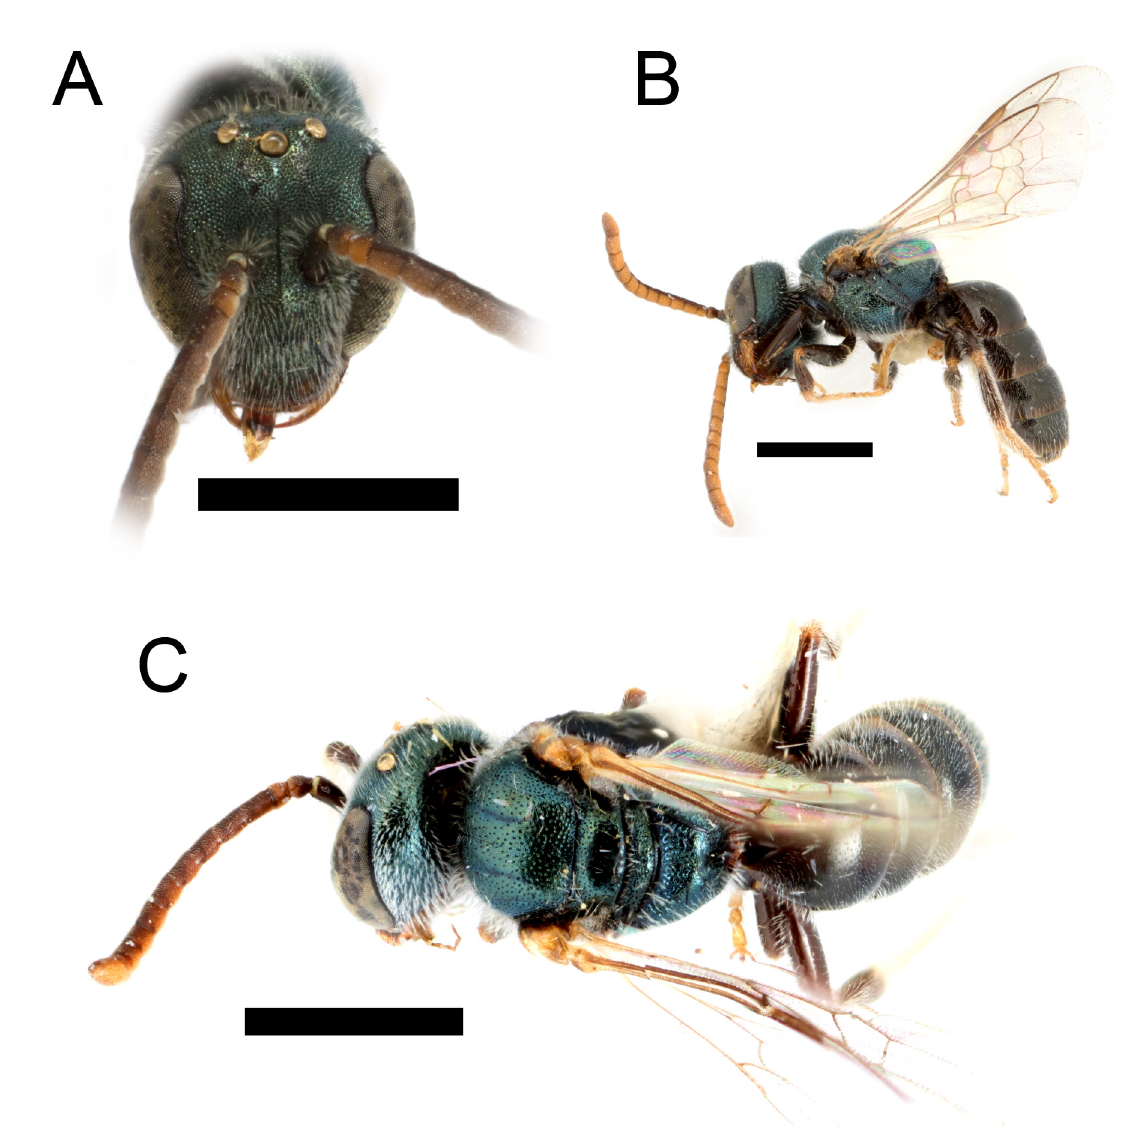
Fig. 10. Lasioglossum enatum sp. nov., ♂. A . Face. B . Lateral habitus. C . Dorsal habitus. Scale bars = 1